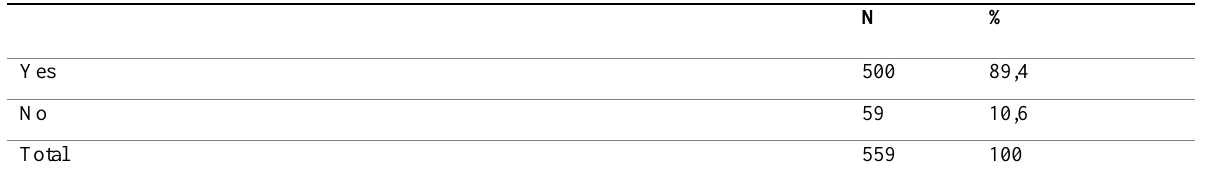
Table 9: Service Training Programs that the Doctors Attended in the Las Two